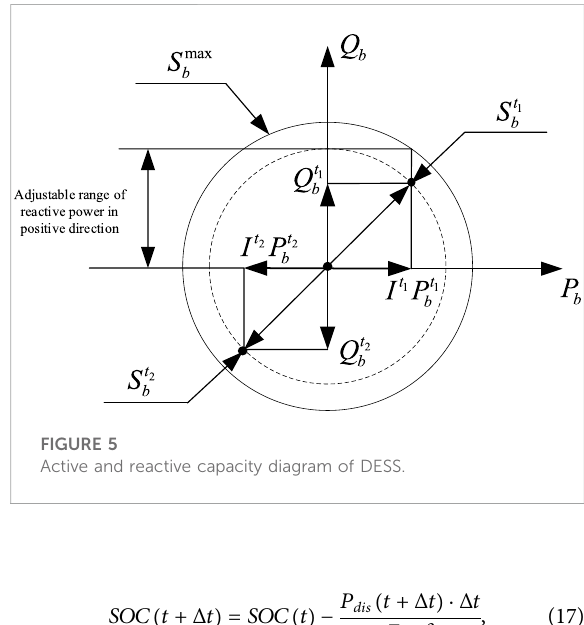
FIGURE 5 Active and reactive capacity diagram of